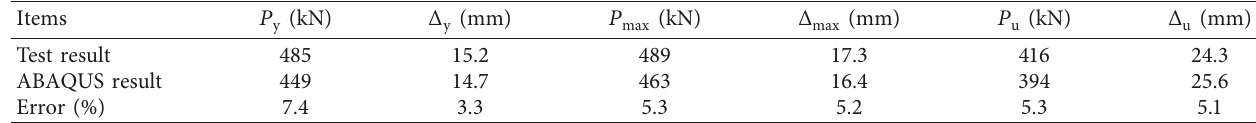
Table 5: Comparison of the finite element analysis and experimental results of specimen C-JA.